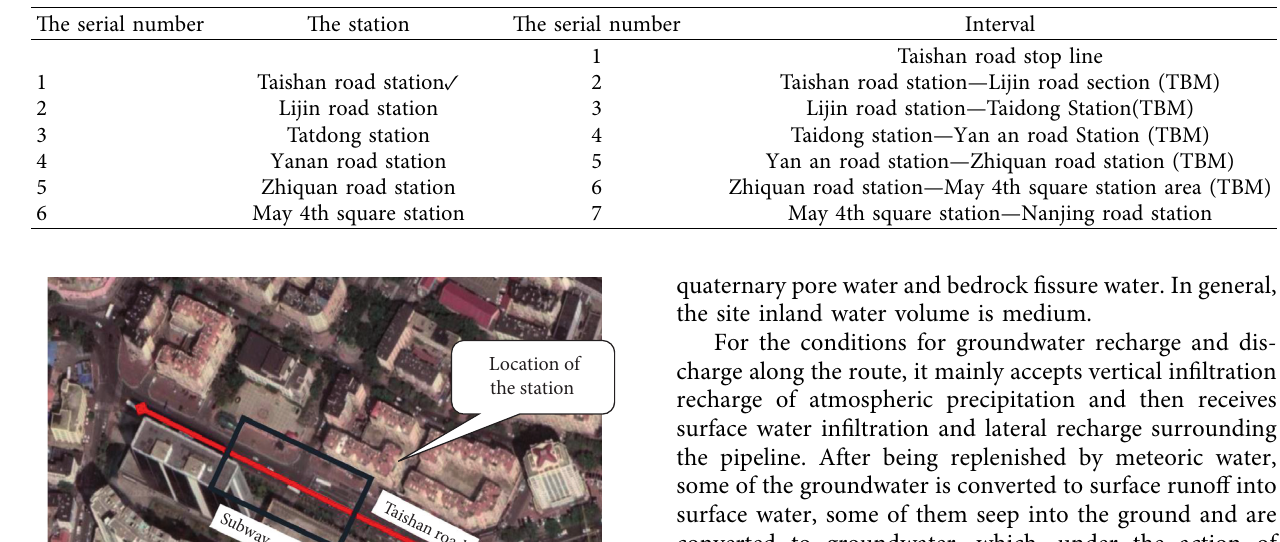
Table 12: Worksites for civil construction of phase 1 of Subway Line M2.